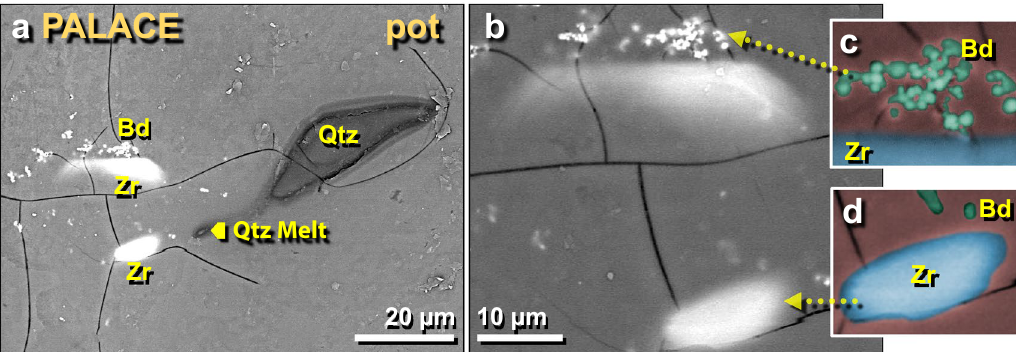
Figure 31. SEM images of other melted zircon grains in palace potsherd. ( a ) Two melted zircon grains adjacent to a previously discussed melted quartz grain; ( b ) close-up of same zircon grains; ( c ) manually constructed EDS- based phase map showing baddeleyite grains in green. The blue area represents melted zircon, while the red background represents the Ca–Al–Si matrix of the melted pottery. ( d ) Manually constructed EDS-based phase map of zircon grain showing small baddeleyite grains in green at the top.